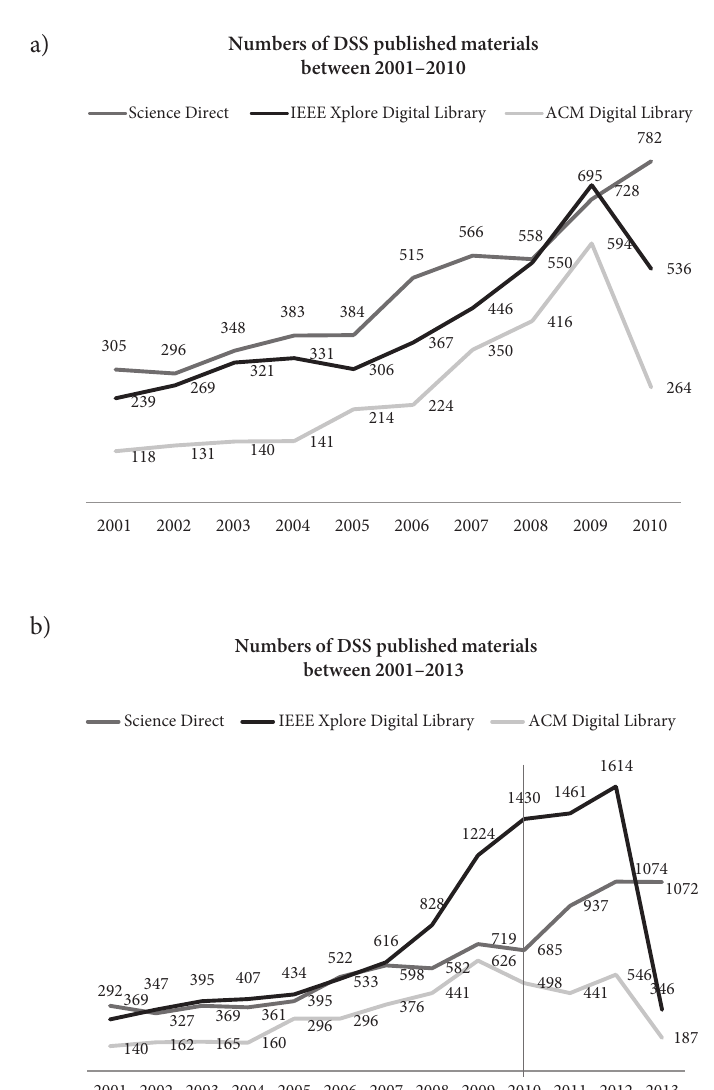
Fig. 5. DSS research yearly production: a) data obtained in 2010); b) data obtained in